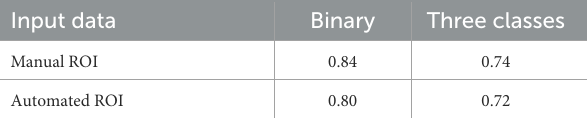
TABLE 3 Results from the experiment on collateral flow grading using only ROI data on our proposed cascaded